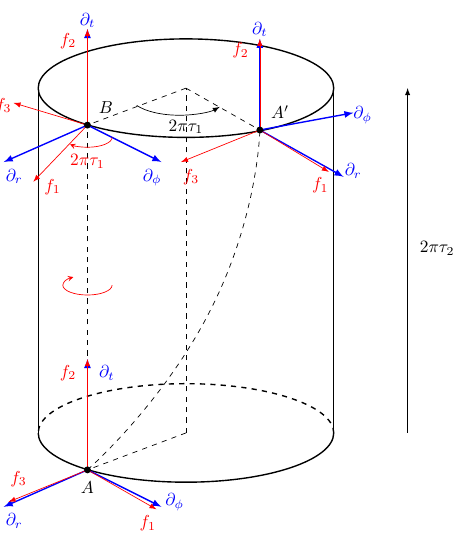
Figure 2 . Framing in thermal AdS arrows denote local frames